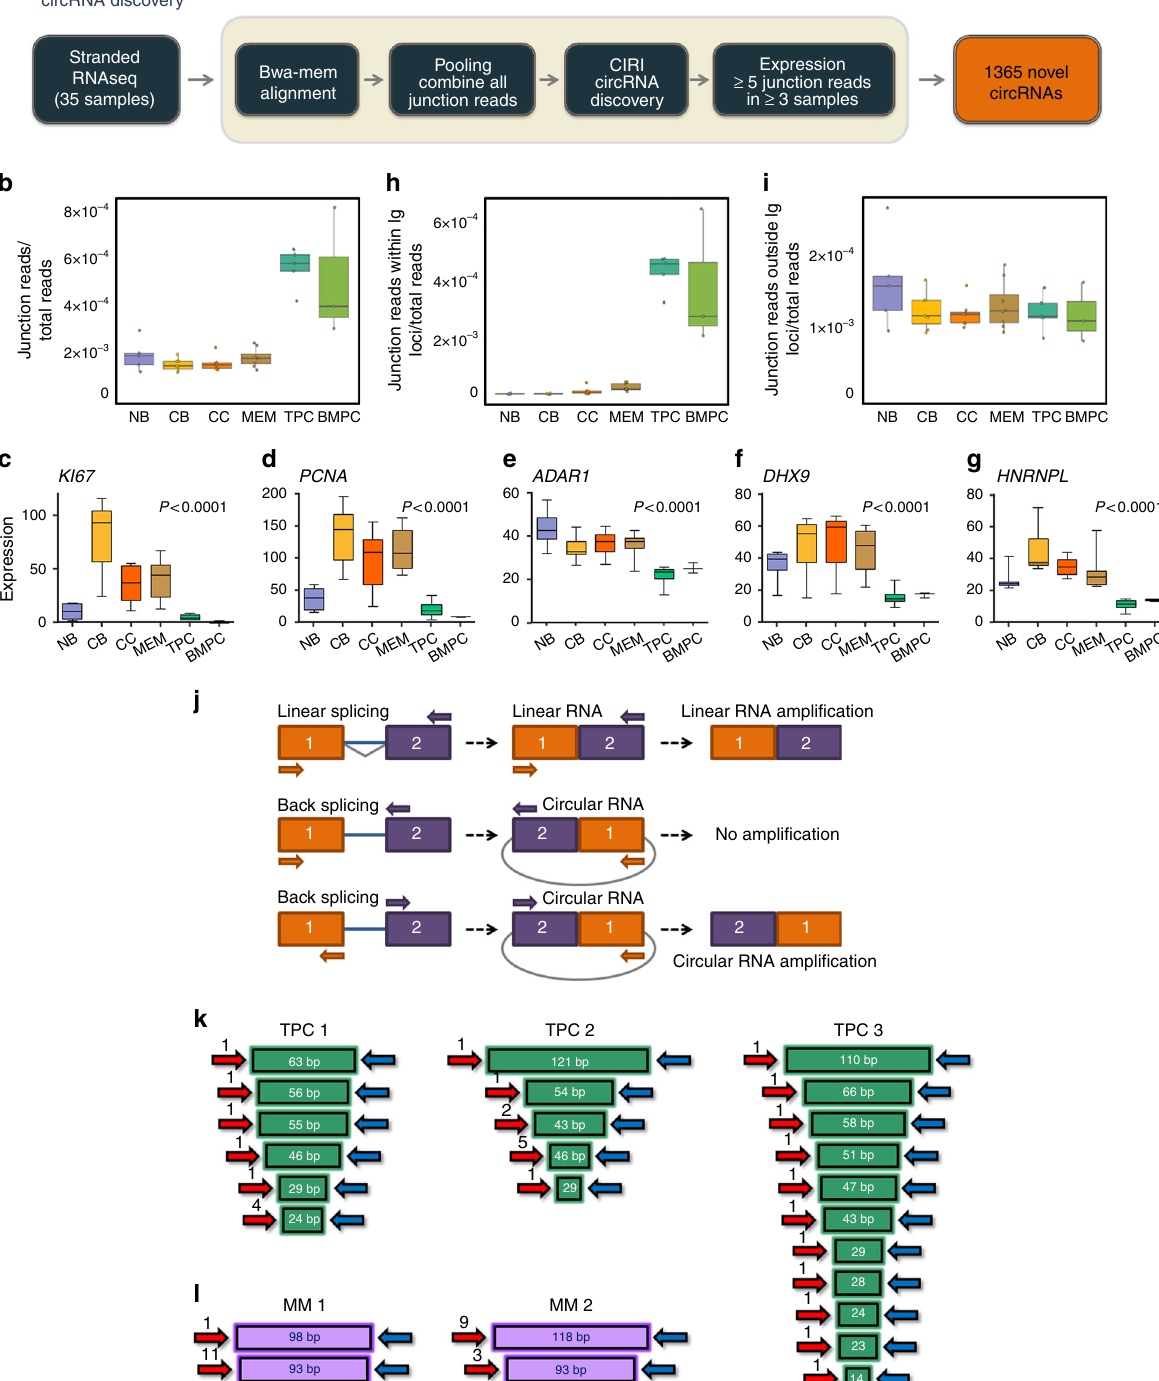
Fig. 8 Identi fi cation of circular RNAs (circRNAs) during the human humoral immune response. a Scheme of pipeline used to de fi ne and identify the putative circRNAs expressed during the humoral immune response. b Box plots showing the average expression of total junction reads from circRNAs. c Box plots showing the expression level of MKI67 , d PCNA , e ADAR1 , f DHX9 , and g HNRNPL genes in different B cell subpopulations. Analysis of variance (ANOVA) test was used for statistical analysis. h , i Box plots showing the average expression of junction reads derived from immunoglobulin (Ig) genes and junction reads derived from non-Ig genes. j Schematic representation of the circRNA formation by back splicing circularization and primers designed to properly amplify by PCR these circRNAs. k , l Cloning and sequencing results of a circRNA derived from Ig locus in normal tonsillar plasma cells or plasma cells from multiple myeloma patients as indicated. Box plots show the median as center, fi rst and third quartiles as the box hinges, whiskers extend to the smallest and largest value no further than the 1.5× interquartile range (IQR) away from the hinges. NB: naive B cells; CB: centroblasts; CC: centrocytes; MEM: memory B cells; TPC: tonsillar plasma cells; BMPC: plasma cells from bone marrow of healthy donors; Ig: immunoglobulin